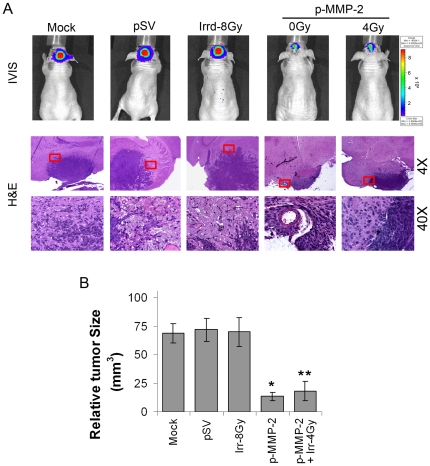
p-MMP-2 combined with radiation inhibits tumor growth in vivo.U-251 (1×106) cells were injected intracerebrally into athymic mice. After ten days, animals were separated into five groups and were treated on alternate days with intracerebral injections of p-SV or p-MMP-2 for a total of 4 doses (60 µg per dose) and 2 doses of radiation (4 Gy per dose) as described in Materials and Methods. Six weeks after the experiment was initiated, mice were euthanized with intracardiac perfusion of PBS, followed by formaldehyde. The brains were then removed. A, Six weeks after the experiment was initiated, an intraperitonal injection of 2.5 mg D-luciferin sodium salt diluted in 50 µL of PBS was given, and animals were photographed under the IVIS camera for fluorescent light emission. The brains were removed and fixed in 10% phosphate-buffered formaldehyde, and the fixed tissue samples were then processed into paraffin blocks. Brain sections (5 µM thick) were stained with hematoxylin and eosin (H&E), and photographed under a light microscope (4× and 40×). B, Every fifth or sixth brain section (5 µM thick) was stained with H&E solution, and the tumor masses (H&E-stained) were manually traced on the microscope attached computer screen. Areas were calculated using Image Pro Discovery Program software (Media Cybernetics, Inc., Silver Spring, MD). The total tumor volume was calculated as the summed area on all slices, multiplied by the slice separation. Columns: mean of area of tumor portion of all mice in the group (n = 8); bars: SD; *p<0.01, **p<0.001, significant difference from mock, p-SV or irradiated controls.